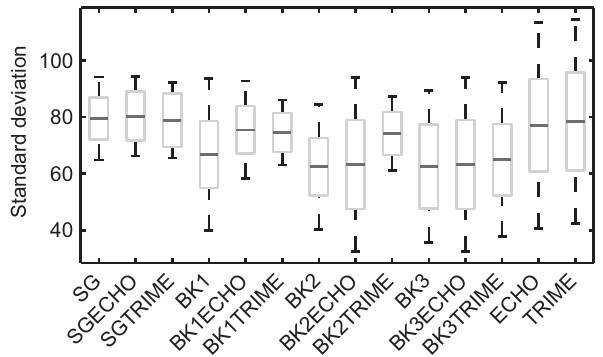
Fig. 5. Performance of the different models for the calibration pe- riod. The median of the box plot is a measure of the signal am- plitude (the standard deviation of the mean signal). The box and whiskers represent the scattering of the standard deviation of the behavioural model runs computed at each time step (the standard deviation of the mean signal was added to the standard deviation of the behavioural model runs at each time